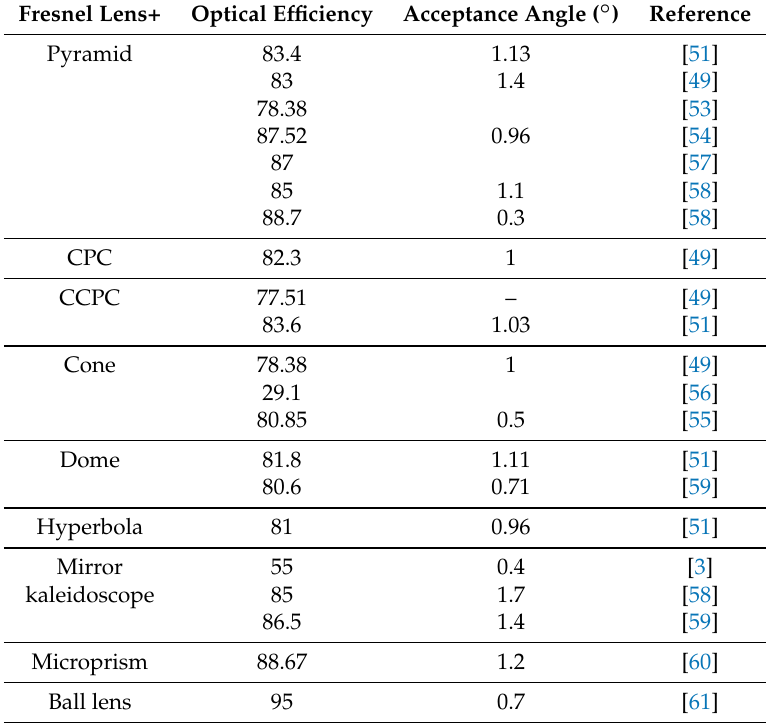
Table 4. Optical efficiency and acceptance angle for each optical